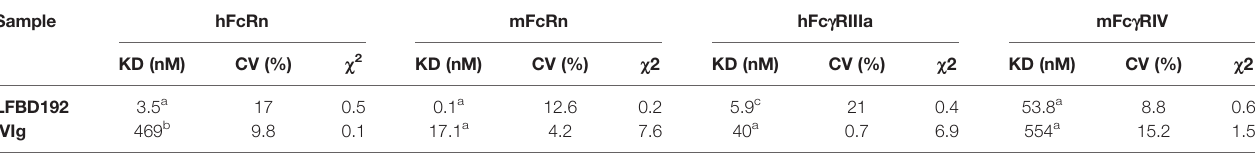
TABLE 2 | Equilibrium dissociation constants of LFBD192 vs IVIg regarding hFcRn, mFcRn, hFc g RIIIa and mFc g RIV at pH6.0 for FcRn (mouse and human) and pH7.4 for hFc g RIIIa and mFc g RIV, c 2 values are provided as an assessment of the goodness of fi t. Sample